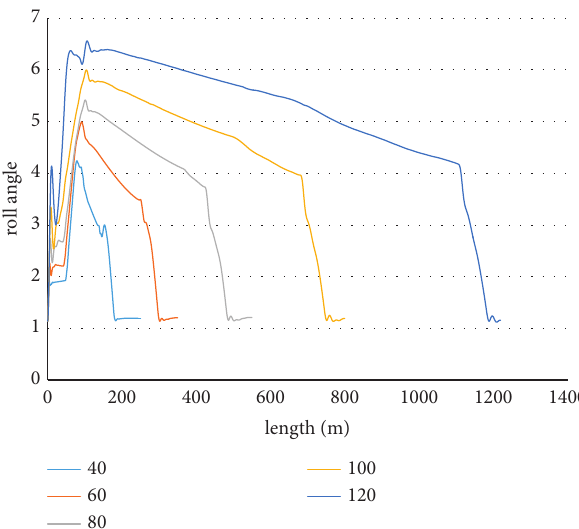
Figure 19: Comparison of overturning angle along the route at different vehicle speeds.